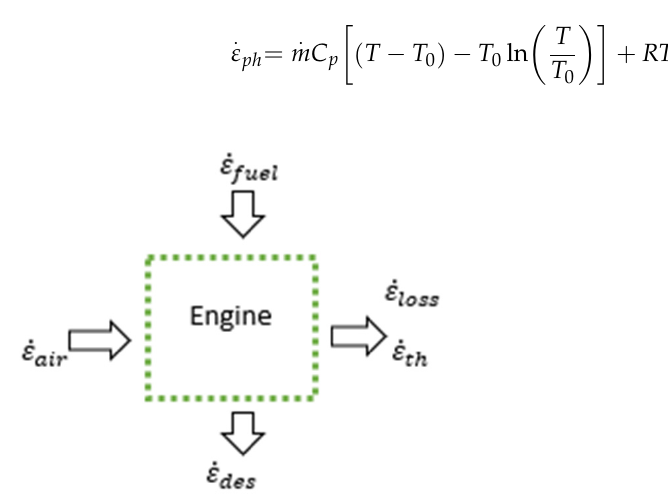
Figure 4. Exergy boundary condition.